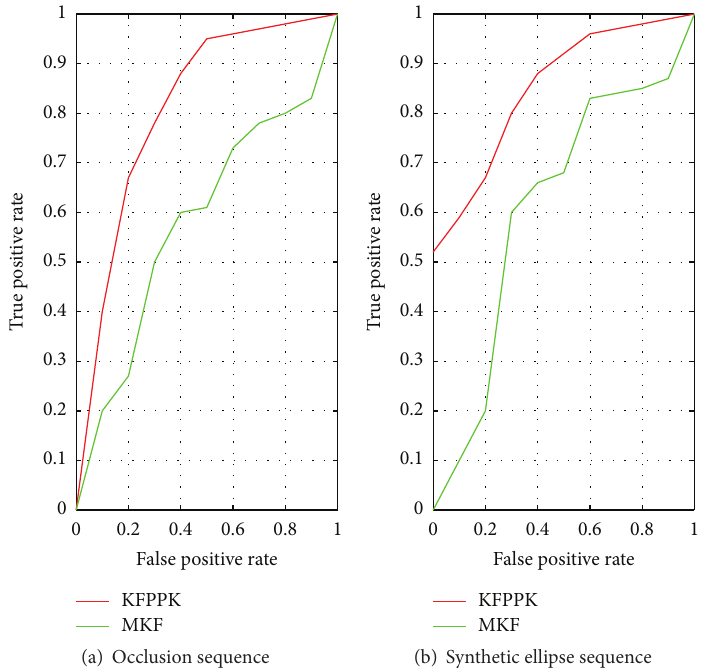
Figure 5: ROC curves by different algorithms on the different videos